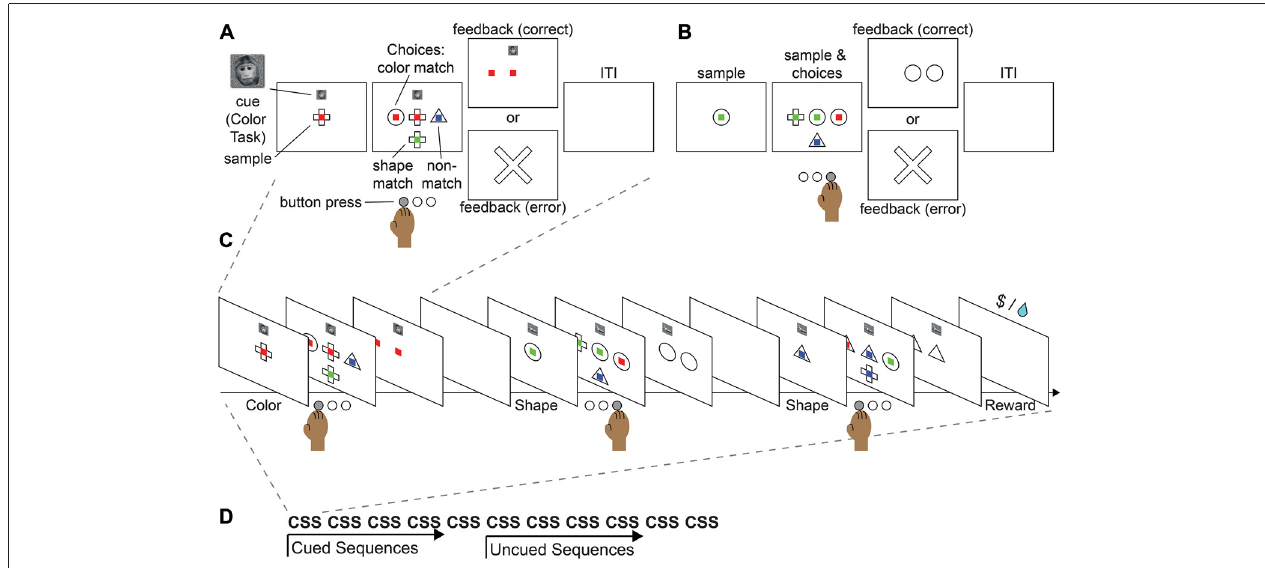
FIGURE 4 | Proposed monkey task sequence paradigm. This task merges the features of the push-pull-turn task, the countermanding task, and WCST into a single sequential paradigm. (A) Example cued trial. (B) Example non-cued trial. (C) Example sequence. (D) Example